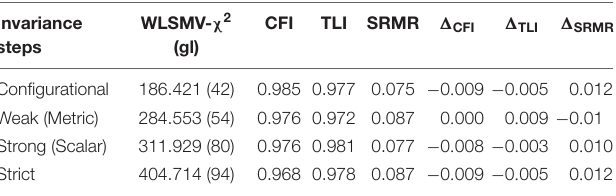
TABLE 5 | Results of between invariance/equivalence